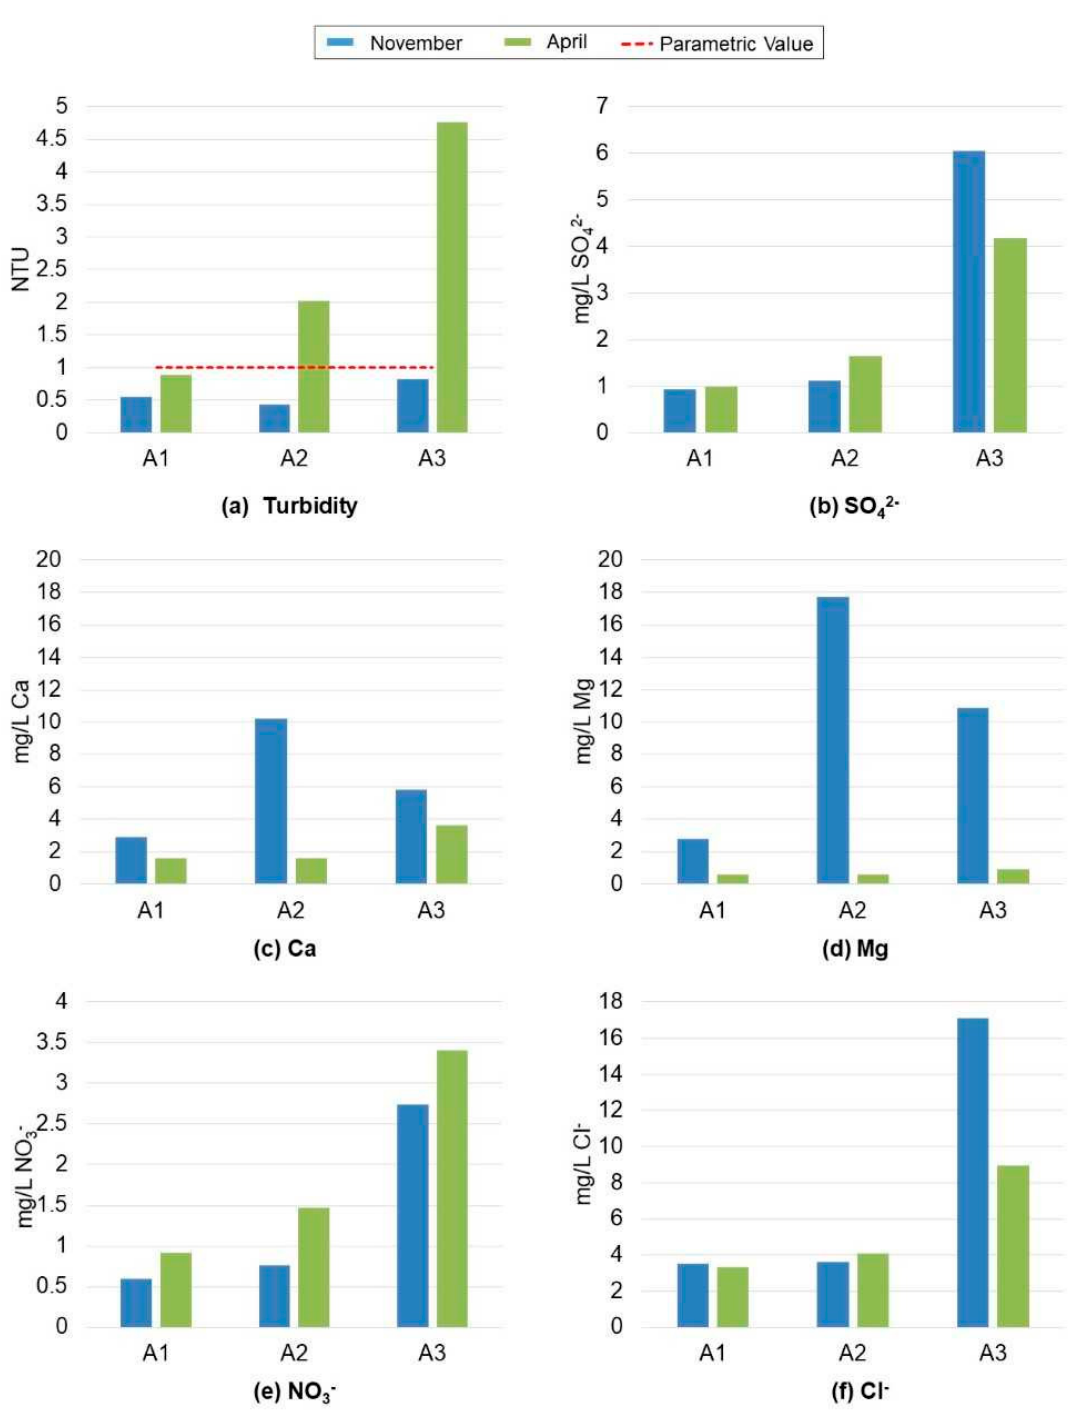
Figure 6. Physicochemical parameters of the water from the Cávado River. Water samples reference the same as in Figure 3. The water pH and temperature values did not show a regular spatial and temporal variation. The water for the sampling point A3 presents the highest EC and total dissolved solids values in both campaigns (Figure 5). The water Eh ranges between 126mV to 185mV without a significant